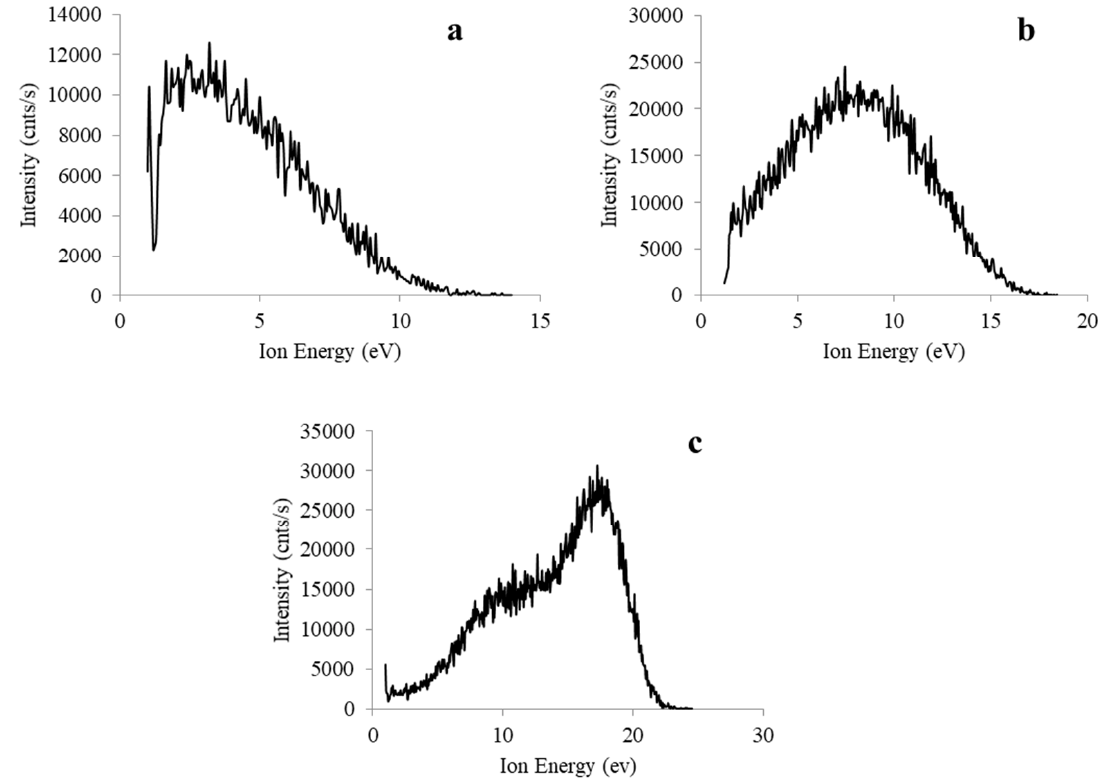
Figure 1. Positive ion energy distribution functions for m/z 154 and fragment ions arriving at the self-biased surface for powers and pressures of ( a ) 5 W 2.17 Pa, ( b ) 25 W 1.95 Pa, and ( c ) 50 W 1.69 Pa.